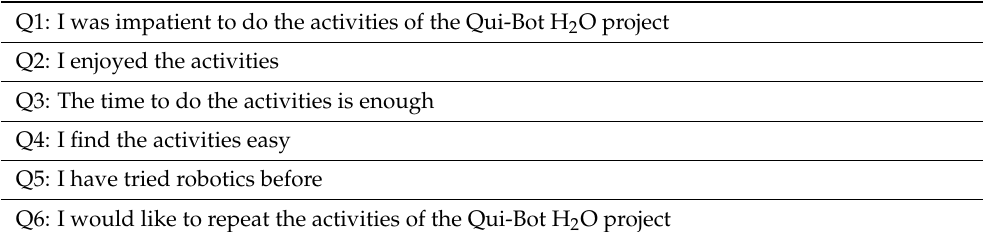
Table 1. A questionnaire specifically designed to measure satisfaction with the